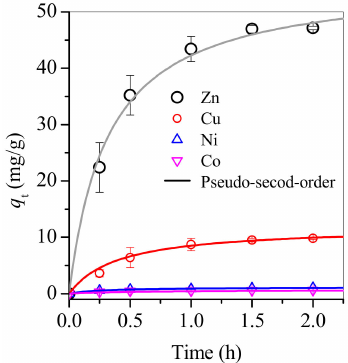
Figure 7. Non-linear plots of the pseudo-second-order model for the adsorption of Zn / Cu on